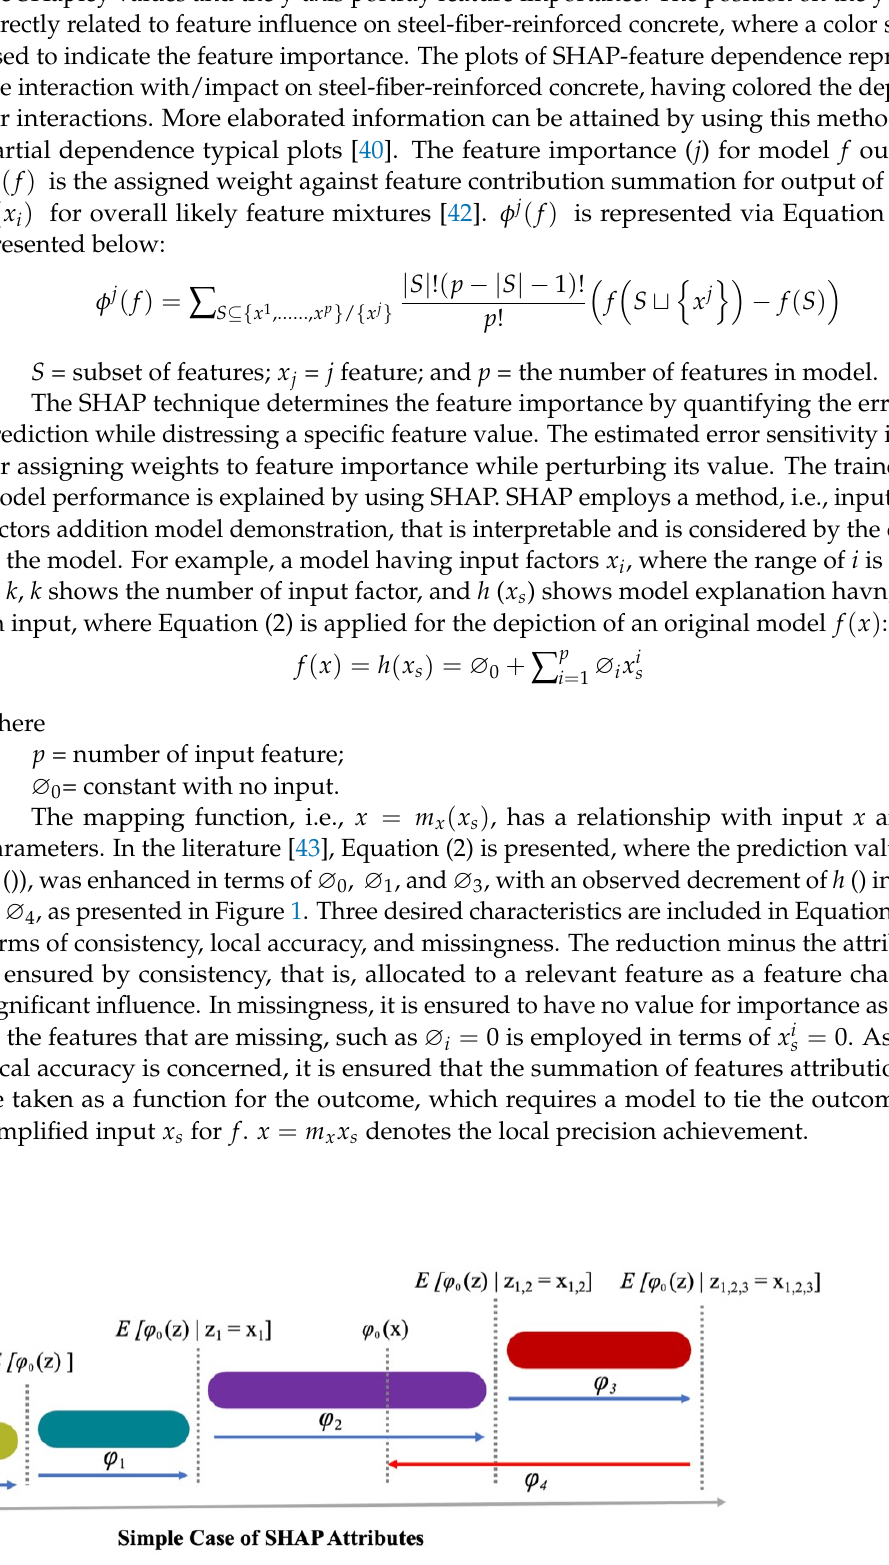
Figure 1. Attributes of SHAP analysis